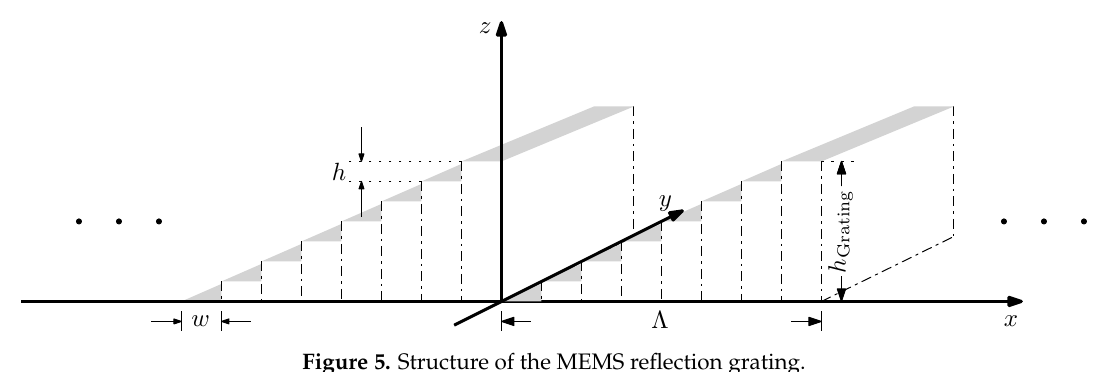
Figure 5. Structure of the MEMS reflection